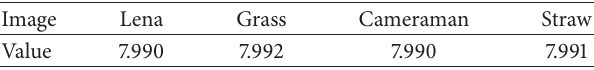
Table 4: Information entropy. Image Lena Grass Cameraman Straw